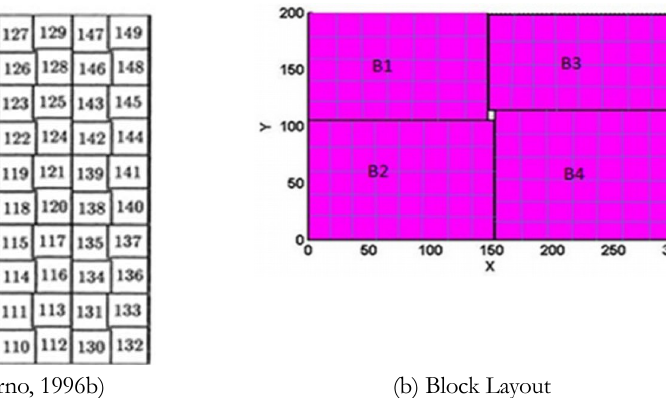
Figure 9. Layouts of Instance